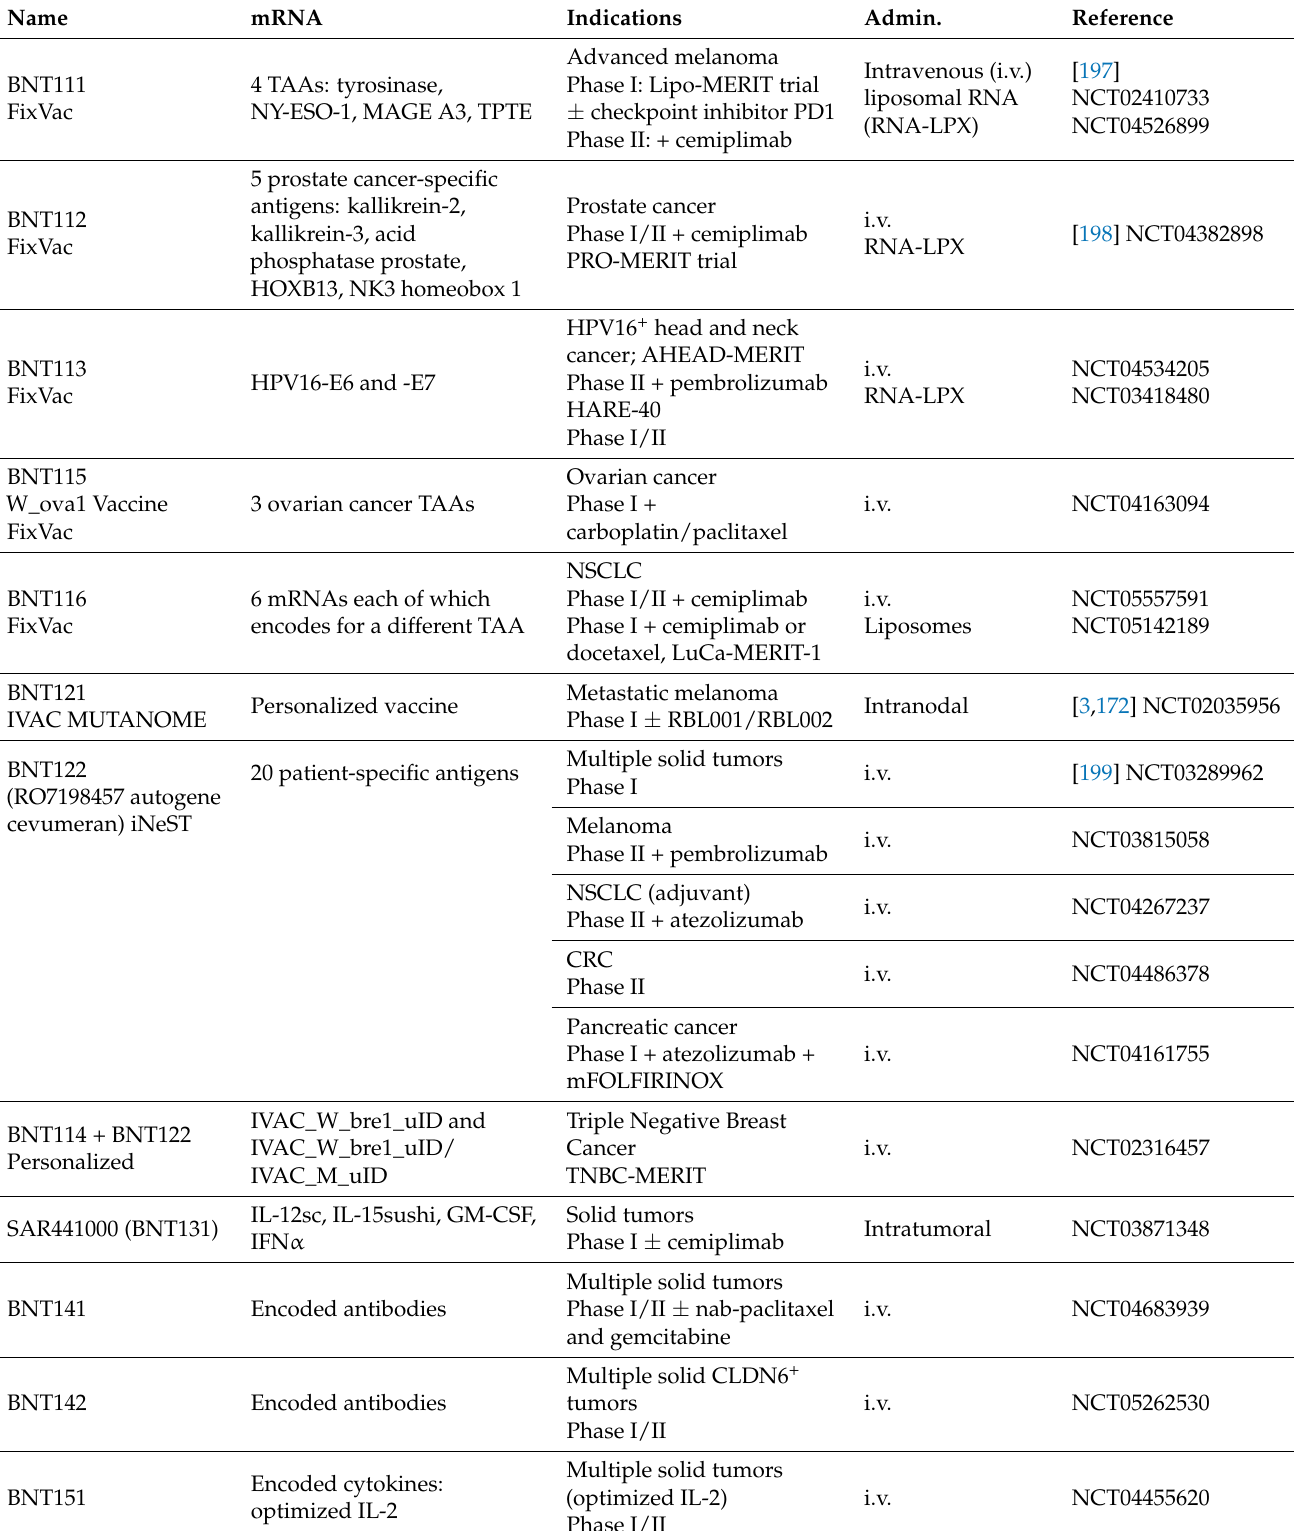
Table 5. Selection of mRNAs in development for cancer treatment. FixVac: Non-mutated antigens shared among patients with a specific cancer type, applicable for almost all types of tumor anti- gens. iNeST: Targeting 20 neoantigens unique to each patient, applicable for almost all types of tumor